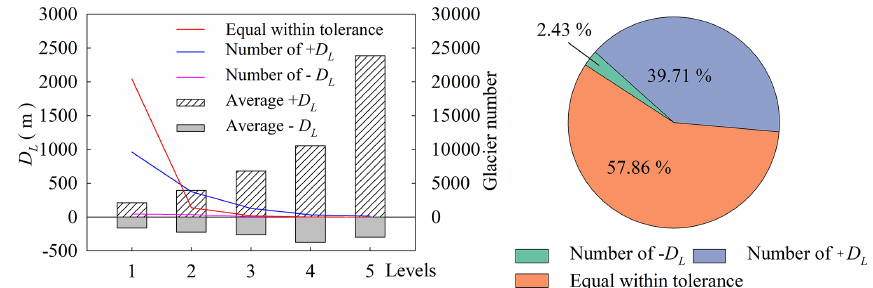
Figure 12. The statistical charts of the difference ( D L ) of the longest length of glaciers by two methods in different glacier sizes.